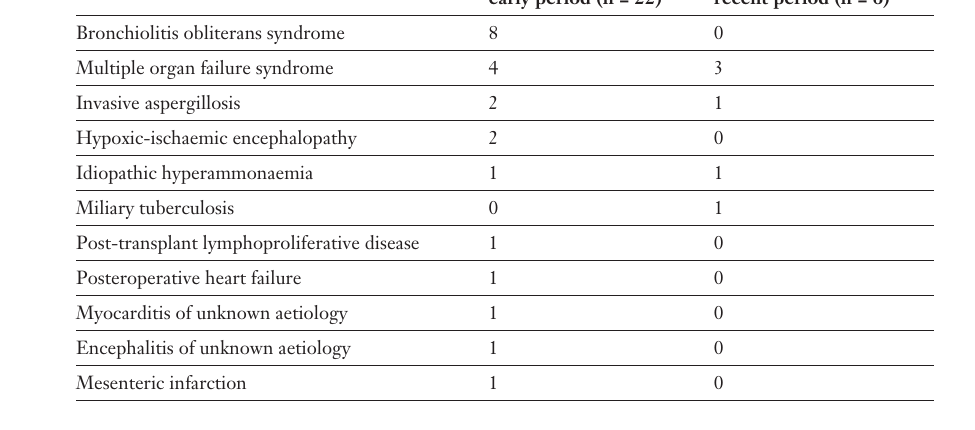
Univariate relative risk of dying for selected baseline values.